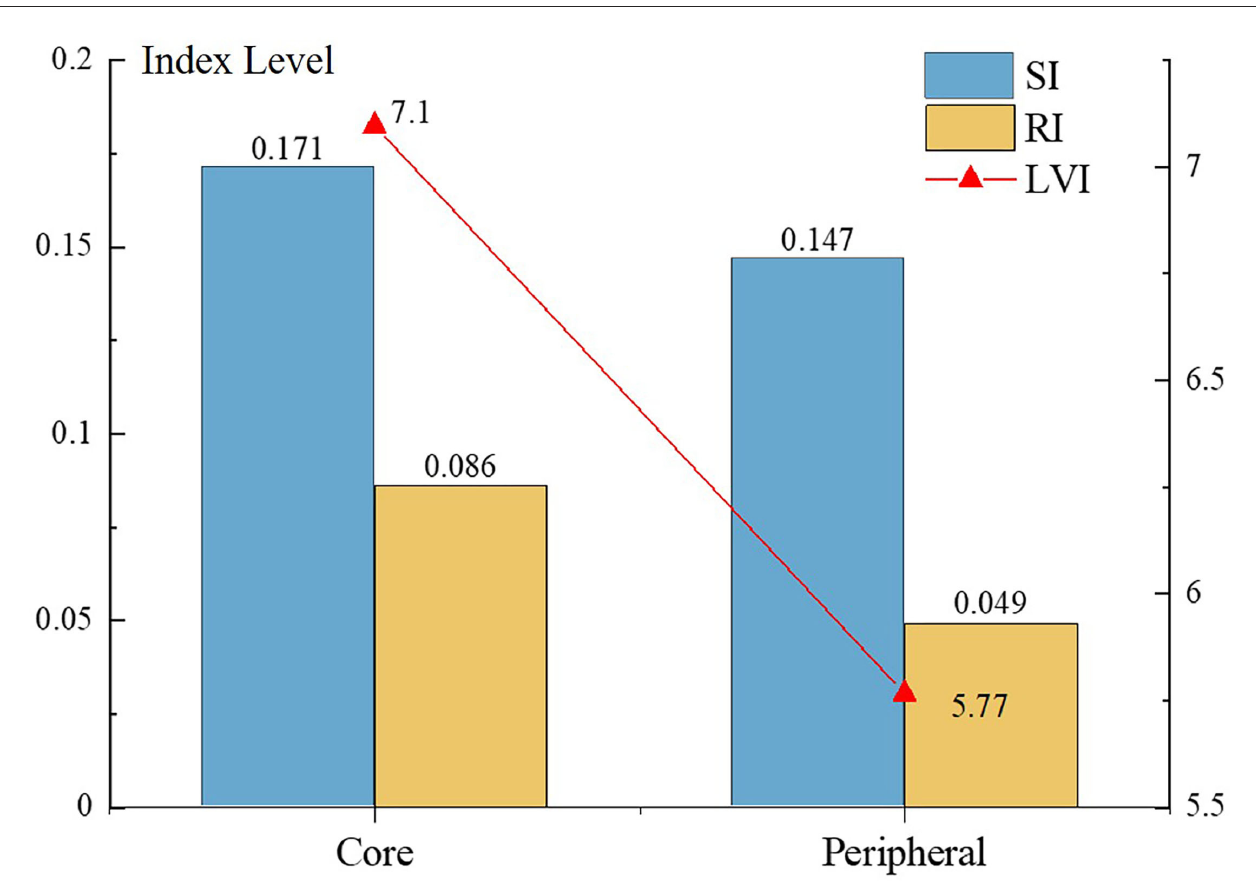
FIGURE4 Spatial variation in livelihood vulnerability levels and characteristics. Blue and yellow bars indicate differences in sensitivity and responsiveness, respectively; red line segments indicate differences in livelihood vulnerability levels. The horizontal axis indicates spatial grouping, the left vertical axis represents the level of the sensitivity and responsiveness index, and the right vertical axis represents the level of the livelihood vulnerability index.